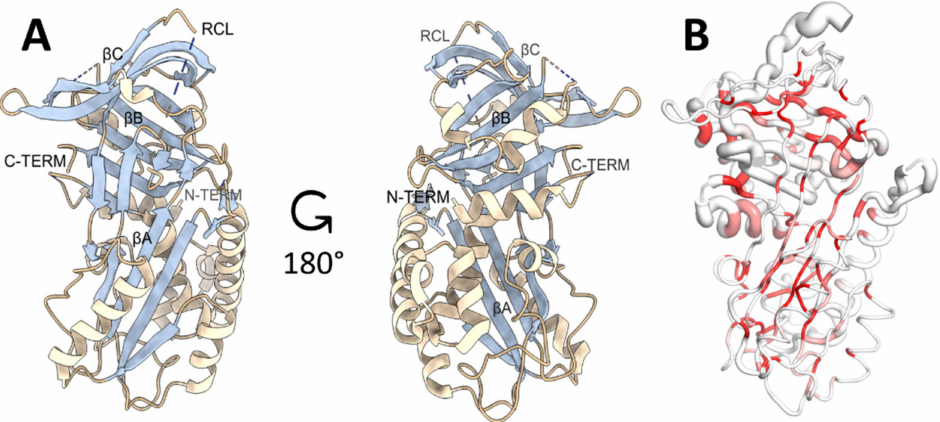
Figure 1. The crystal structure of Serine protease inhibitor from S. mansoni (SmSPI) (PDB 6SSV). ( A ) Cartoon representation of the secondary structure organization: alpha helices (bisque) and beta sheets (light blue) are highlighted and named after conventional Serpin nomenclature. Gaps in the structure are indicated by dashed lines. ( B ) Sausage representation of the conserved regions among 153 structural homologs: the size of the tube is proportional to the mean r.m.s. deviation per residue between C α pairs. White: low sequence conservation; Red: sequence identity. Graphic representations were generated with UCSF Chimera software (Version 1.13.1, The Regents of the University of California, Oakland, CA, USA) and The PyMOL Molecular Graphics System, Version 2.0 Schrödinger, LLC, New York, NY, USA [47,48].